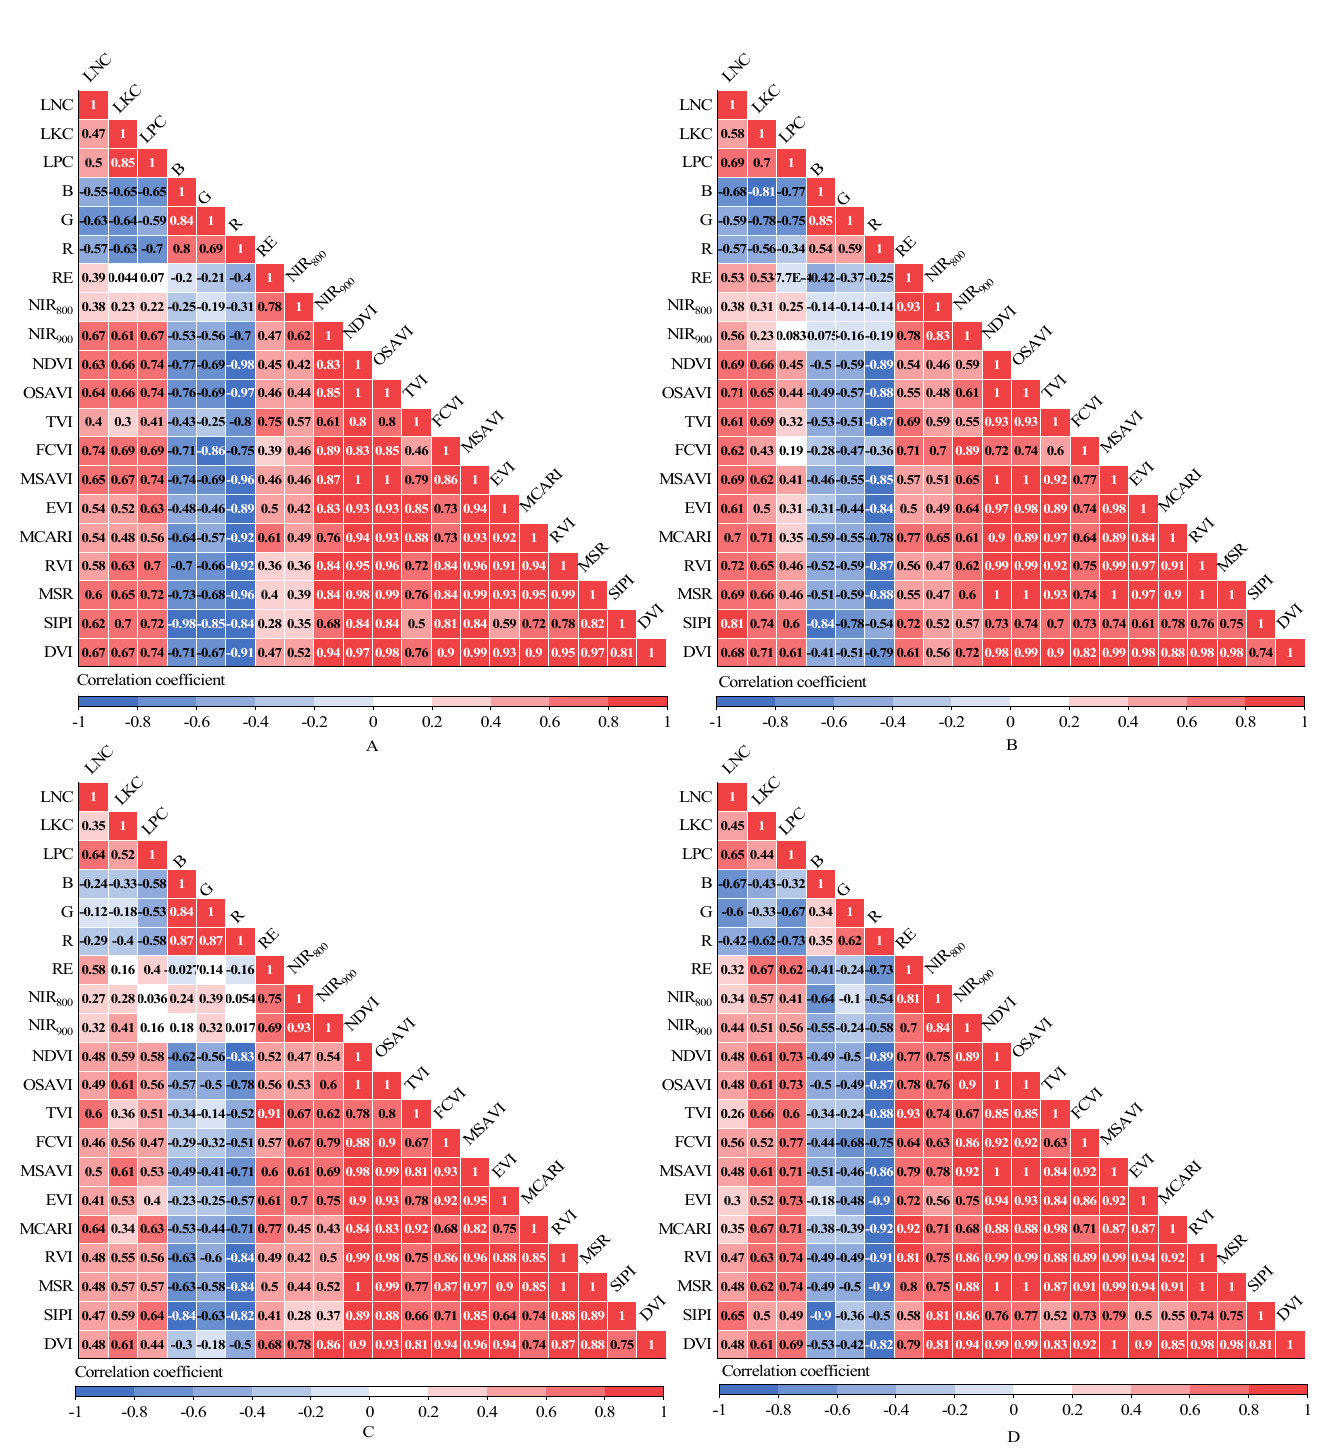
Figure 5. ( A ) Correlation coefficients between spectral variables and the LNC, LKC, LPC in the new shoot growth stage. ( B ) Correlation coefficients between spectral variables and the LNC, LKC, LPC in the flowering stage. ( C ) Correlation coefficients between spectral variables and the LNC, LKC, LPC in the fruit expansion stage. ( D ) Correlation coefficients between spectral variables and the LNC, LKC, LPC in the veraison and maturity stage.